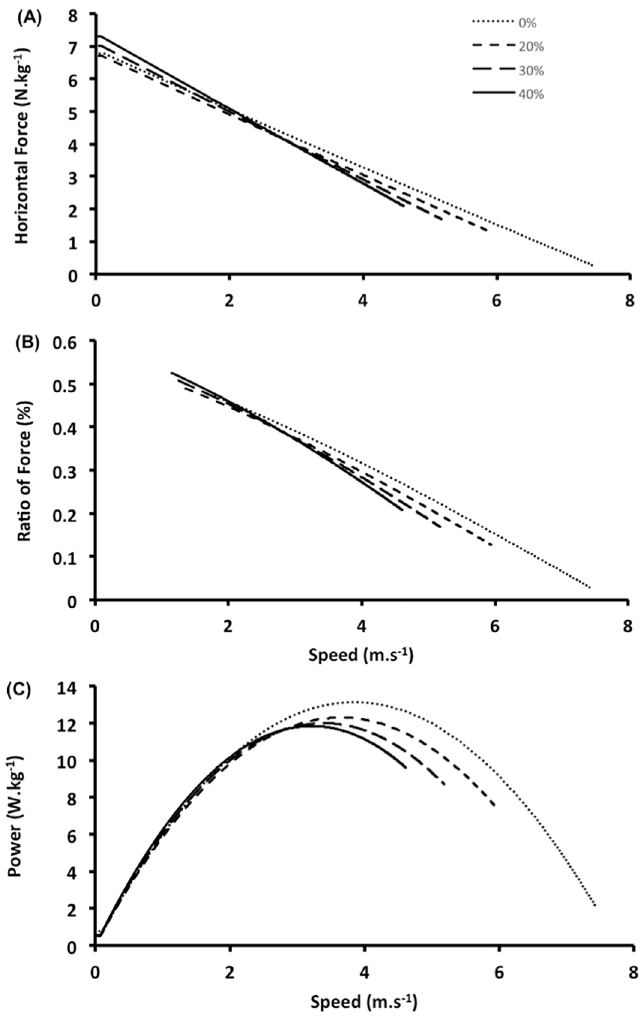
Fig 2. The key mechanical parameters of sprint as a function of speed. Conditions: 0%- unload, 20%, 30%, 40% of body mass. (A) Force-velocity relationship. (B) Ratio of force ( RF )as a function of speed. The D the decrease in RF with speed (in this figure: 0% = -0.085; 20% = -0.085; 30% = -0.091; 40% = -0.084). (C) Power- velocity relationship. These data are from one representative individual.